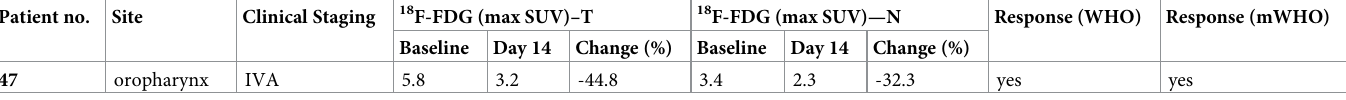
Clinical Staging 18 F-FDG (max SUV)–T